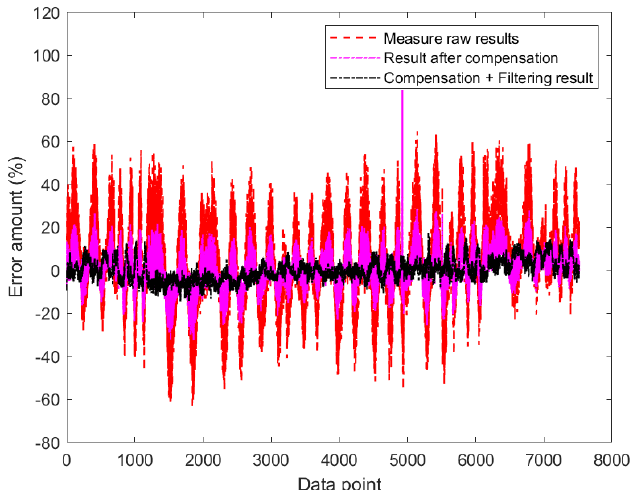
Figure 12. Data error before and after filtering.